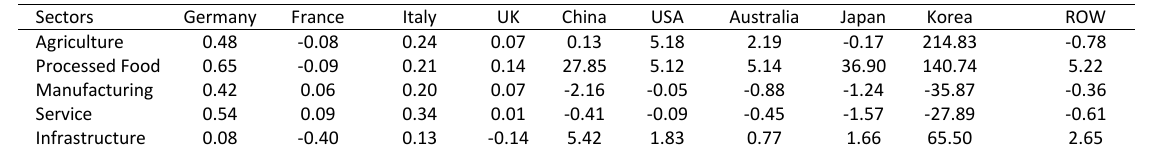
Table 5: Change in aggregate imports by sector (%)